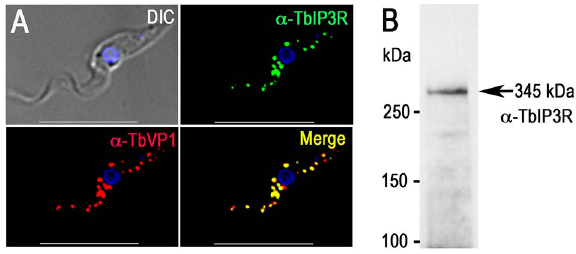
Fig. 2. Immunofluorescence microscopy analysis of TbIP 3 R. (A) TbIP 3 R co-localized with TbVP1 in acidocalcisomes of PCF trypano- somes (Pearson’s correlation coefficient of 0.8399). Yellow in merge images indicates co-localization. Scale bars =10 m m. (B) Western blot analysis of TbIP 3 R expressed in PCF trypanosomes using polyclonal anti- TbIP 3 R antibody. Lysate containing 30 m g of protein from PCF trypanosomes was subjected to SDS/PAGE on 4–15% polyacrylamide gel, and transferred to a nitrocellulose membrane. Molecular weight markers at left and arrow shows the band corresponding to TbIP 3